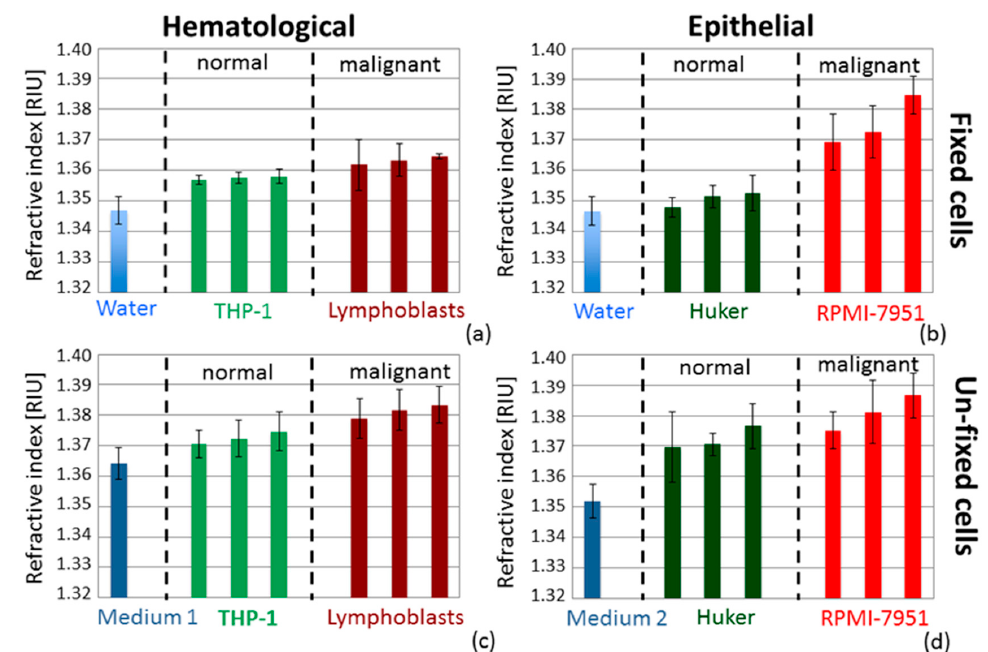
Figure 6. Column bar graphs with average and standard deviation values of refractive index obtained for four different cell lines and the medium in which they are suspended (i.e., water or Medium 1 and 2). Each graph compares RI values of normal and malignant cells with the same origin. ( a , b ) Fixed cells; ( c , d ) Un-fixed cells; ( a , c ) Hematological cells; ( b , d ) Epithelial